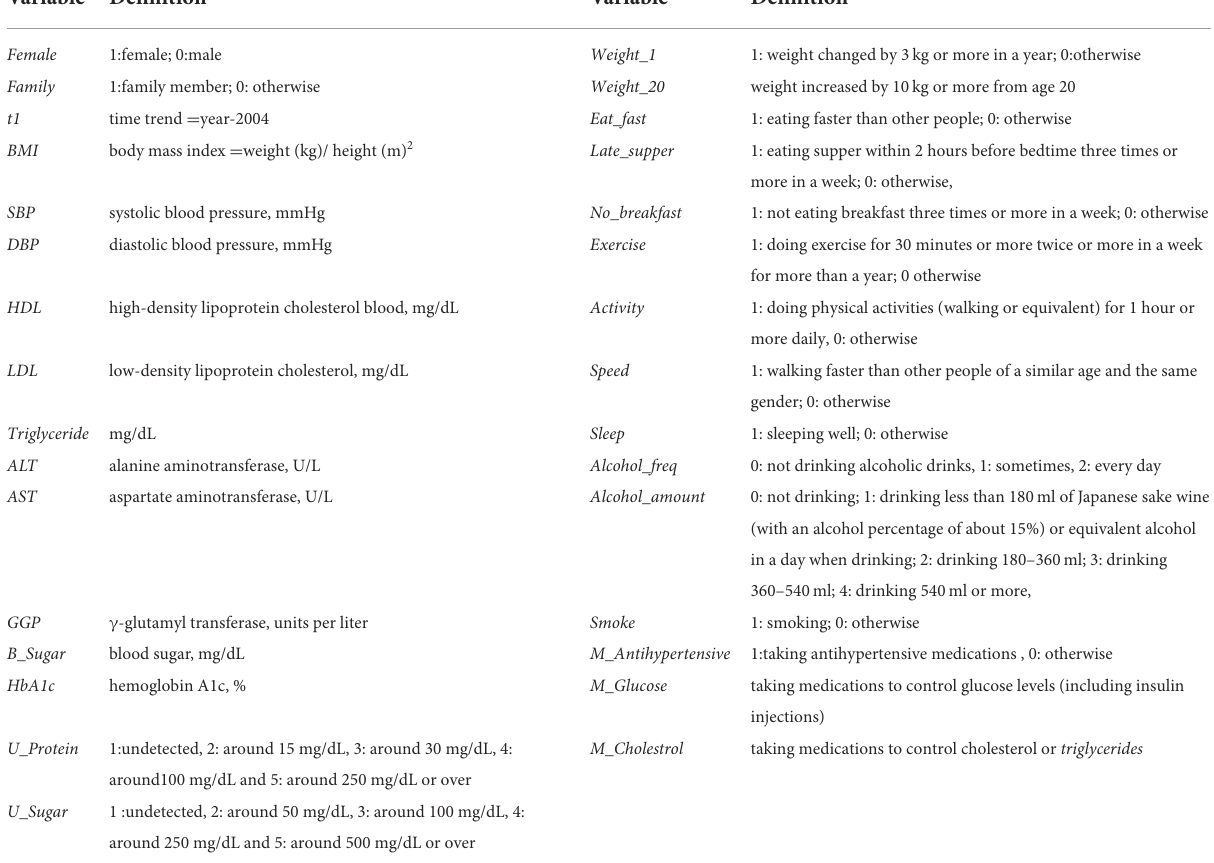
TABLE 3 Definition of